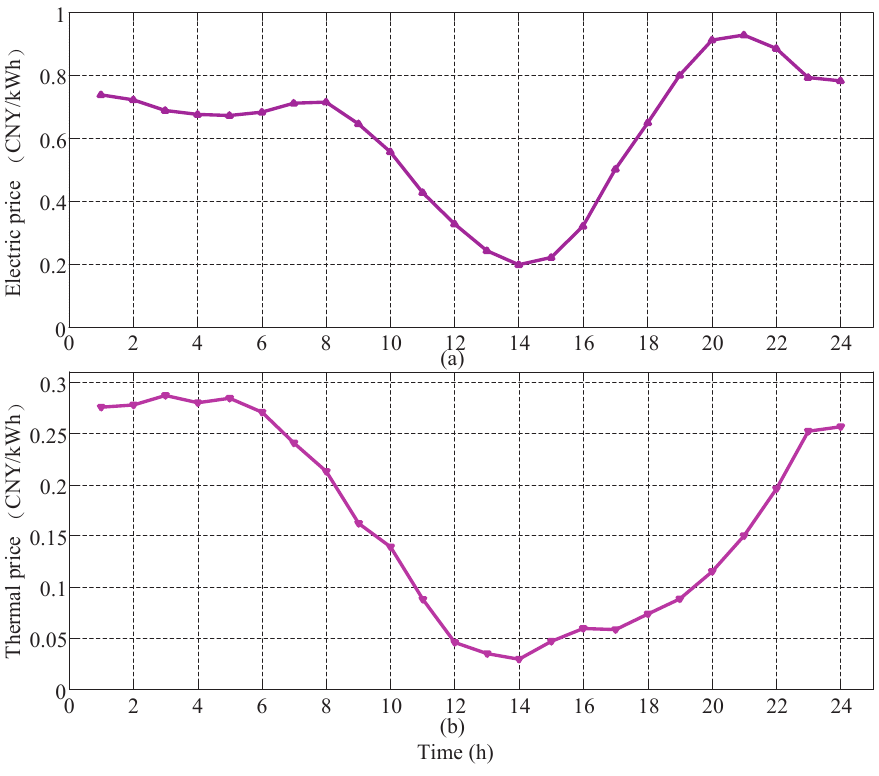
Figure 6. ( a ) Electric price and ( b ) thermal price during the